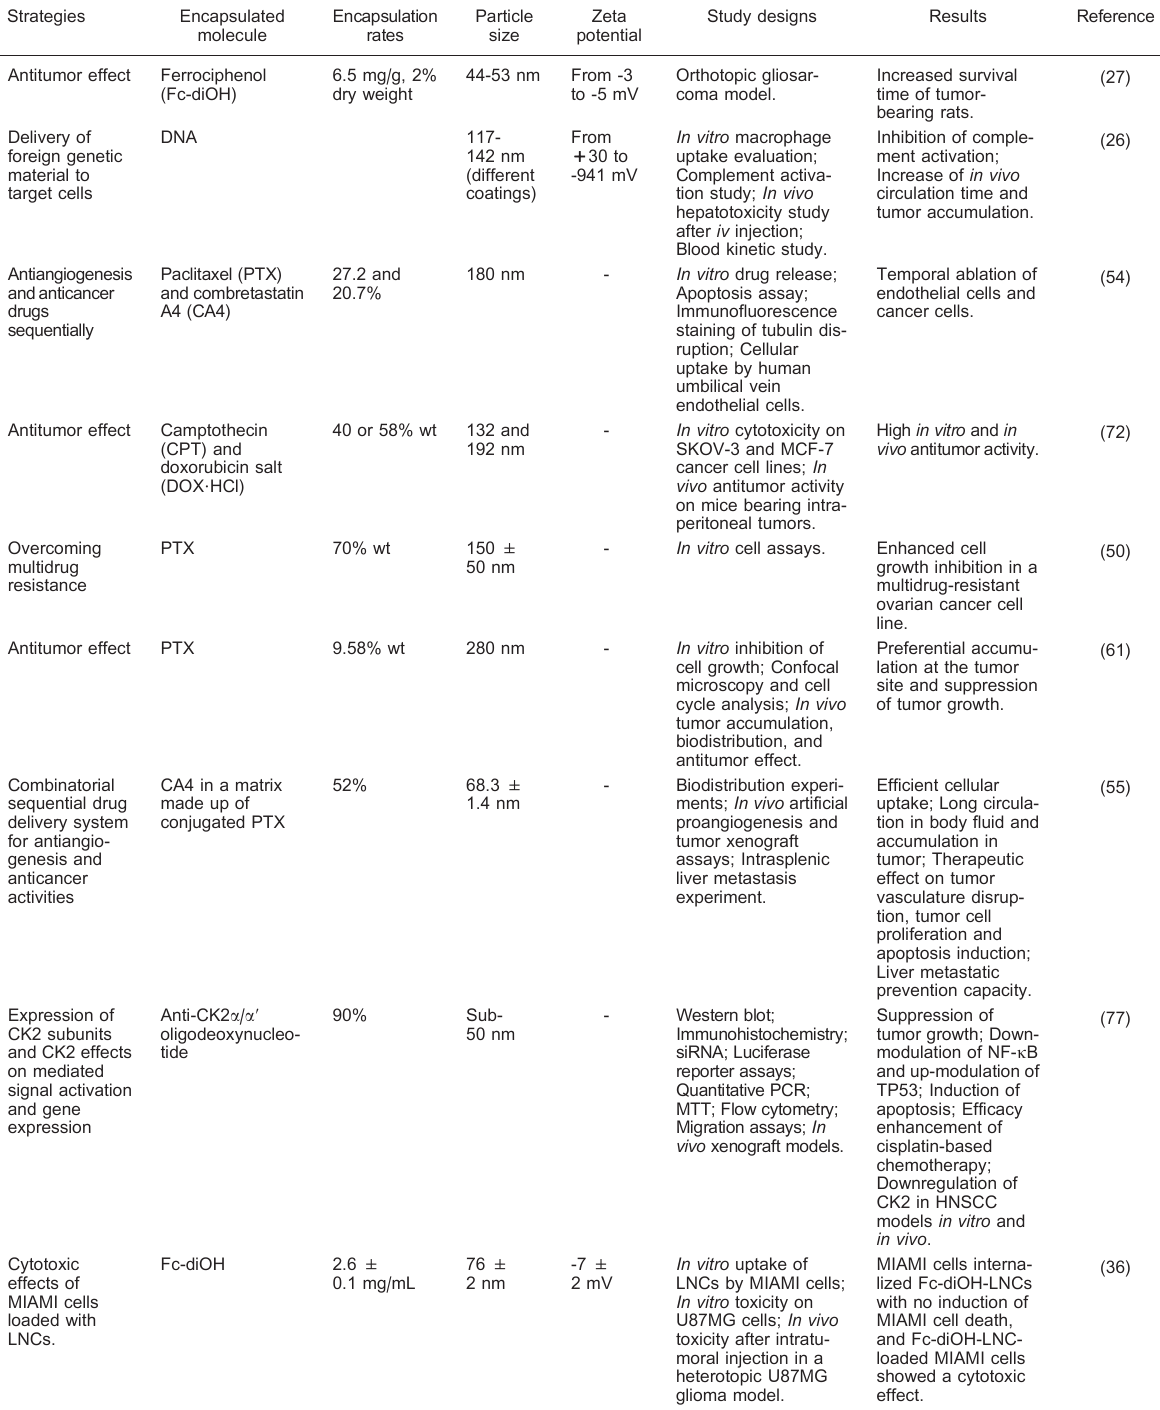
Table 1. Recent strategies for cancer treatment using